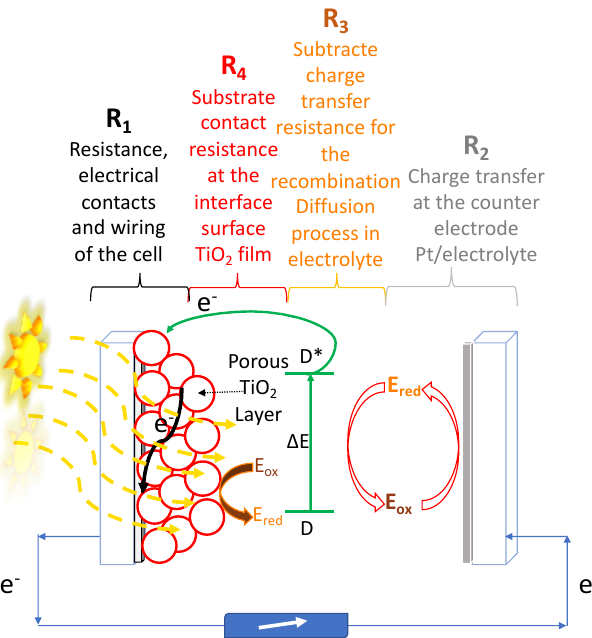
Scheme 2. Illustration of a Dye Sensitized Solar Cell (DSSC) with the main components (Working Principles) and the kind and causes of resistances that can occur in the DSSCs.